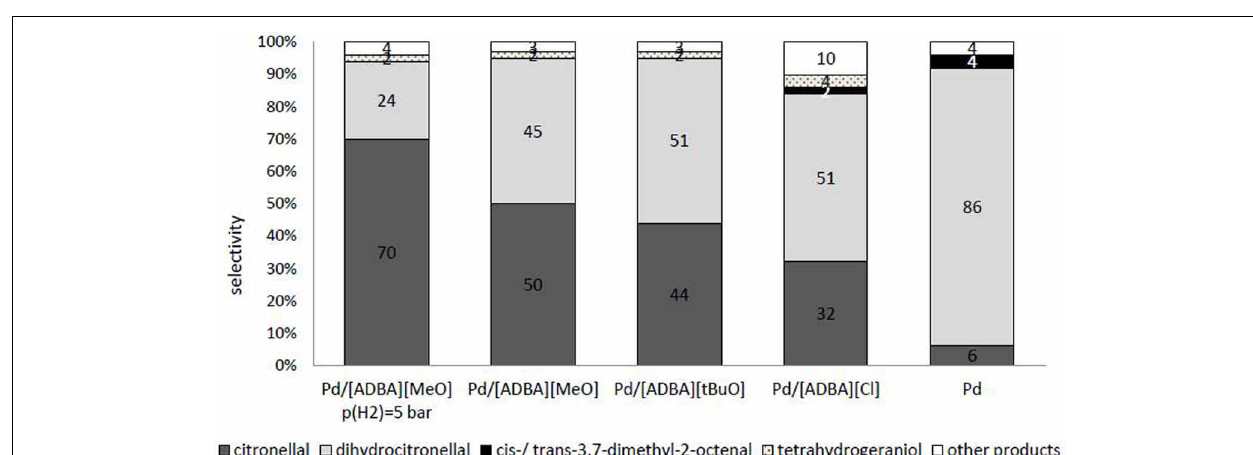
FIGURE 7 | Comparison of the selectivities of the products from citral hydrogenation over supported ionic liquid catalysts containing an alkaline ionic liquid after complete conversion. Traditional heterogeneous catalyst (palladium nanoparticles on ACC) and catalyst